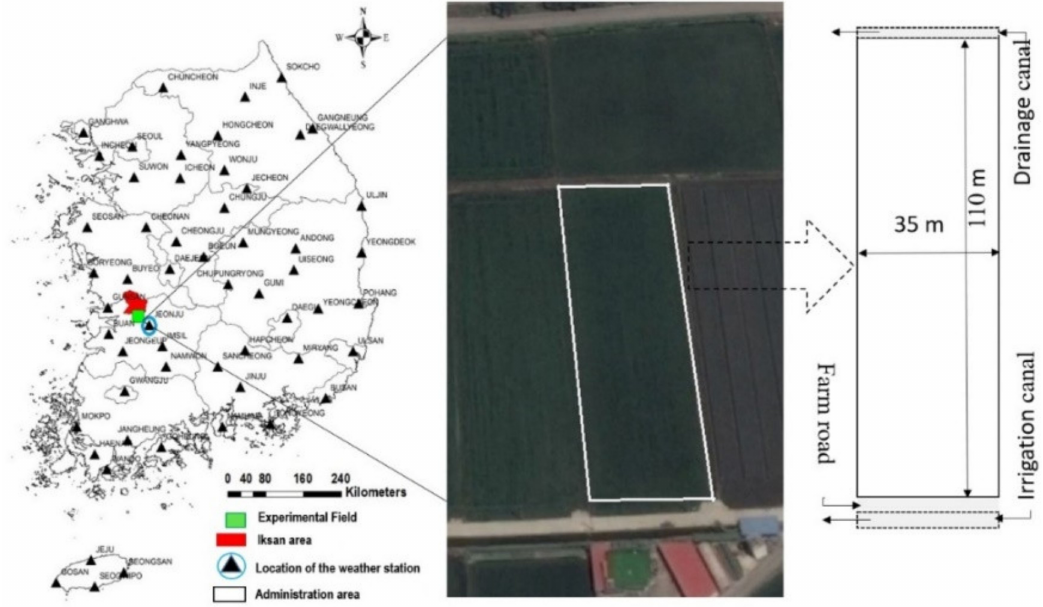
Figure 1. Geographical location of the study area. Schematic map of experimental plots located